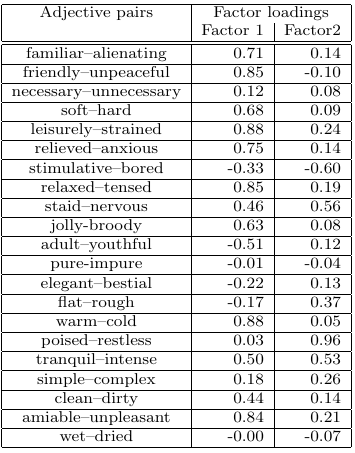
Table 1: Adjective pairs and factor loadings (Varimax nor- malized)